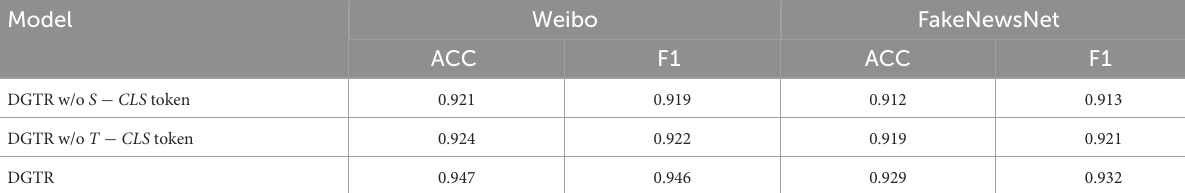
TABLE 5 Ablation experiment to verify the effect of CLS token.